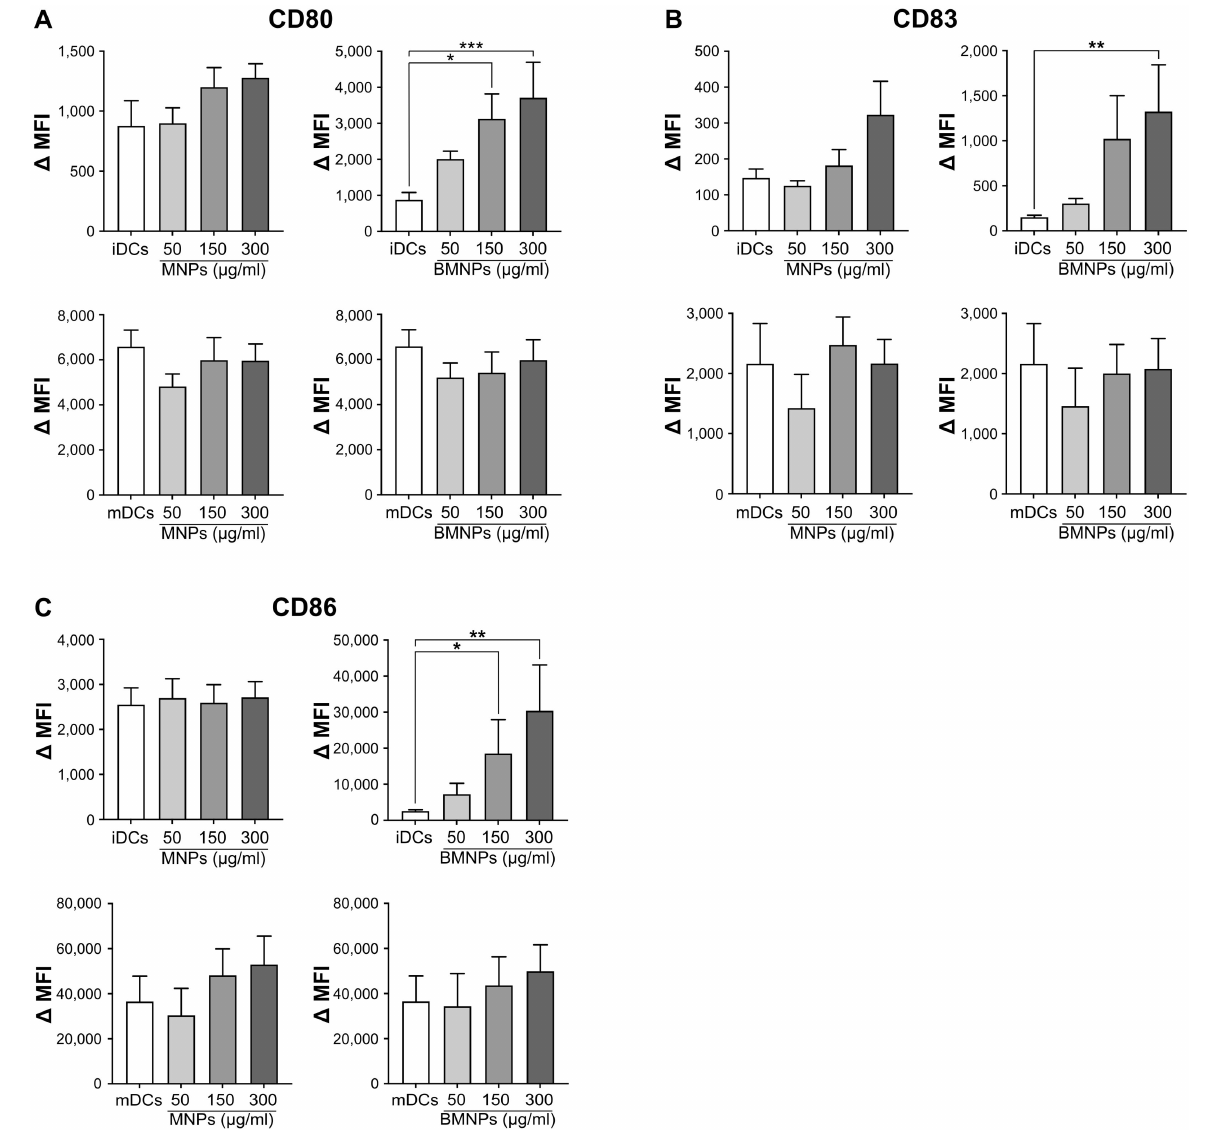
Figure 4. Effects of MNPs and BMNPs on monocyte-derived DC maturation. DCs cultured in the absence (iDCs) or presence (mDCs) of 100 ng/mL LPS were treated for 24 h with the indicated doses of MNPs or BMNPs. The expression of maturation markers CD80 ( A ), CD83 ( B ), and CD86 ( C ) was assessed by flow cytometry and shown as ∆ MFI values. The results are expressed as the mean value + SEM of five independent experiments. * p < 0.05; ** p < 0.01; *** p < 0.001 by Friedman